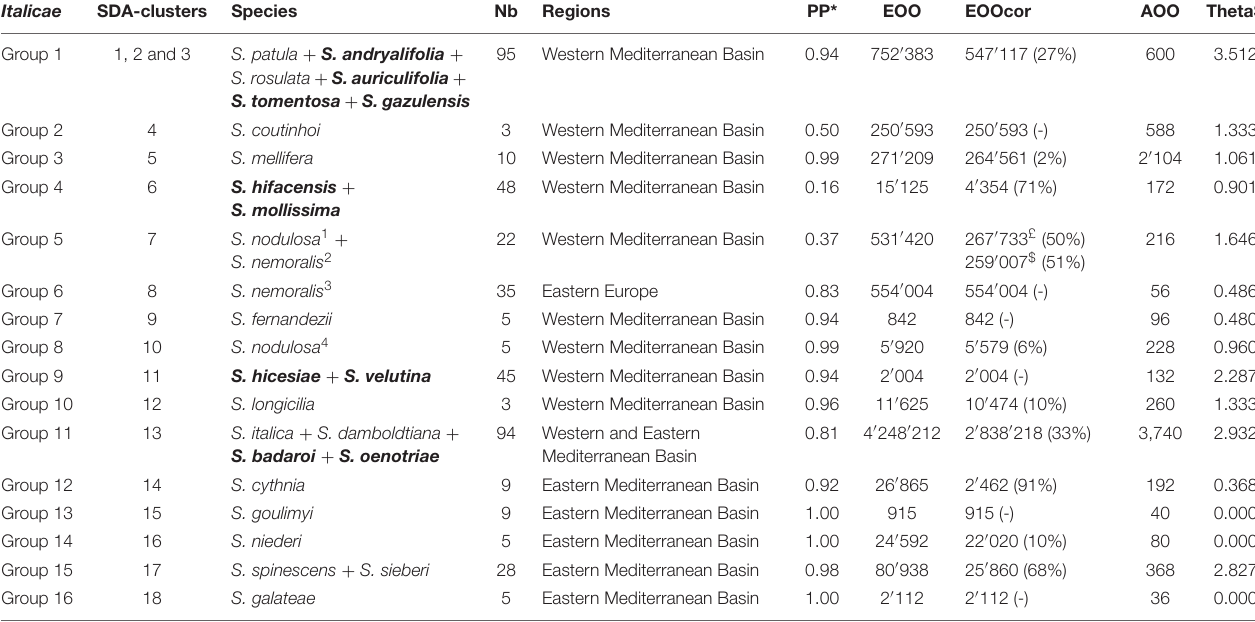
TABLE 2 | Composition of the 16 final groups within Italicae , ranked from top to down in Figure 1 and SDA-clusters in Figure 2 , with their associated ThetaS as an estimation of θ , extend of occurrence (EOO) and area of occupancy (AOO) in km 2 as computed in GeoCAT.